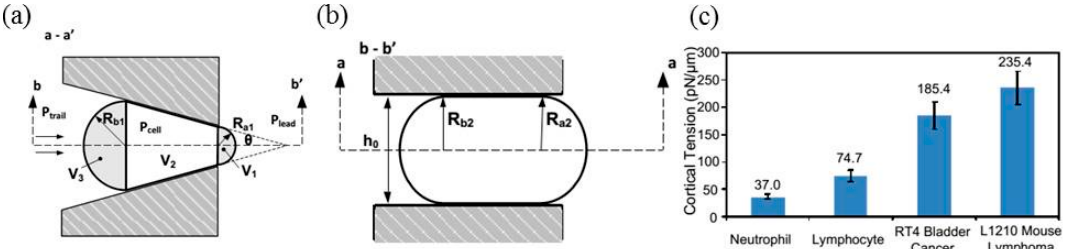
Figure 6. ( a ) Top view; and ( b ) side view illustration of a single RBC at the critical point of the constriction; ( c ) Comparison of the quantified cortical tensions from four different cell types. Reproduced with permission from [46].